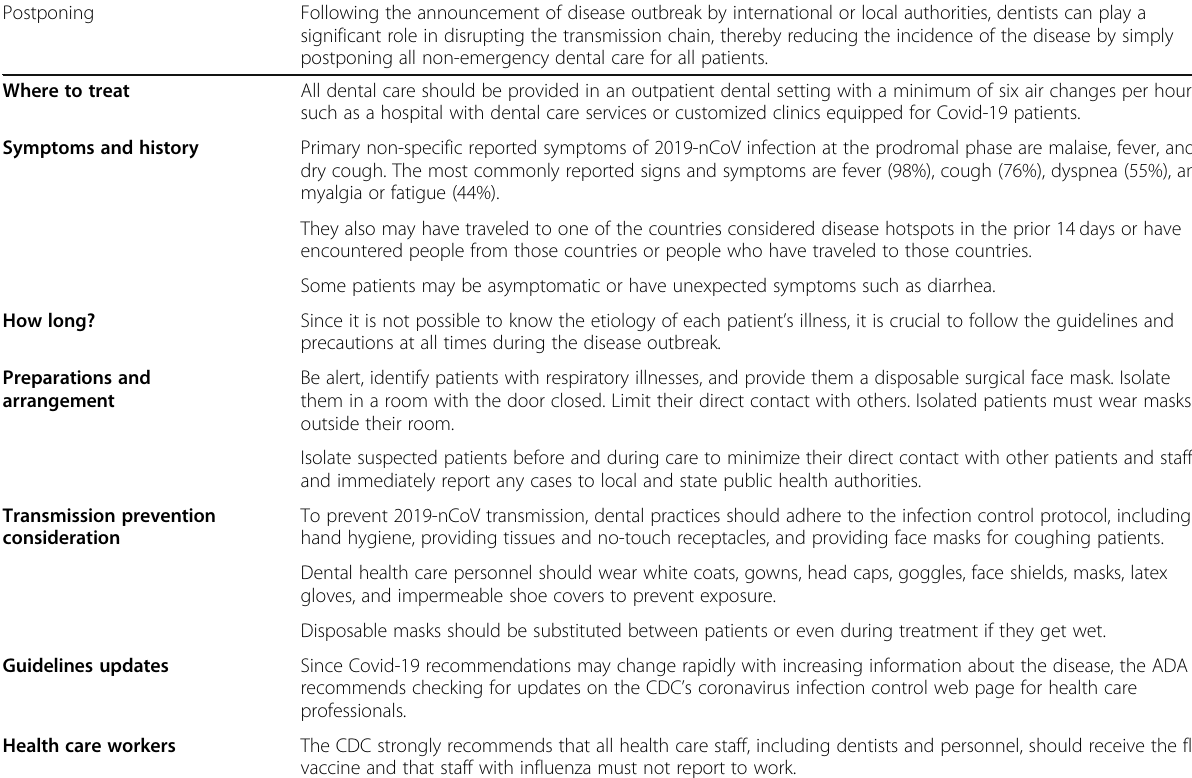
Table 2 Standard precautions based on CDC and ADA guidelines for dentists on the coronavirus disease [40 –